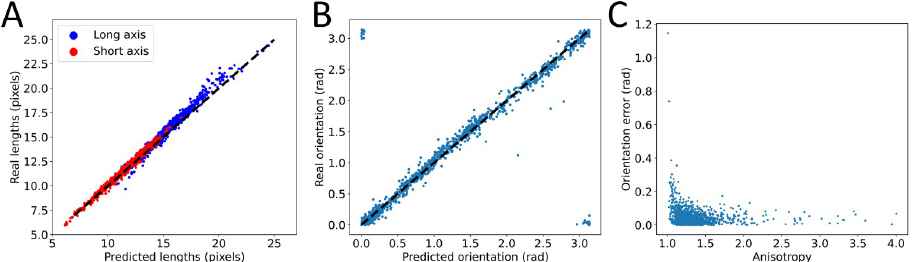
Fig 6. Performance of the best 3-conv model. A: comparison of predicted and true long and short axes for the re- trained optimal 3-conv model. B: comparison of predicted and true orientation for the same model. In A and B, dashed black lines represent identity. C: effect of anisotropy on the performance of the model in predicting orientation.